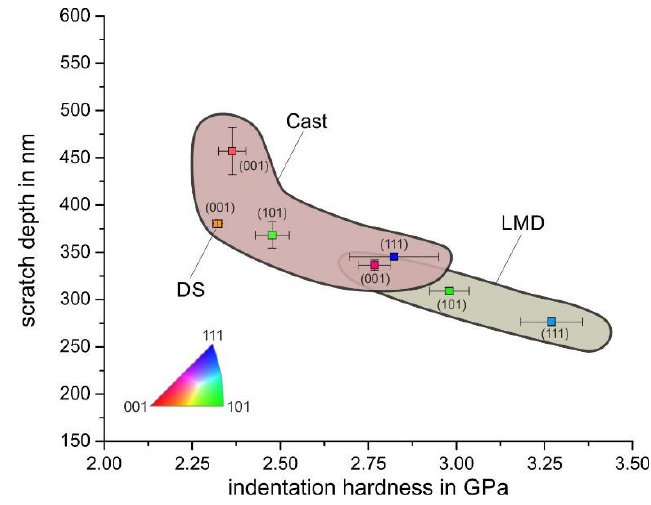
Figure 16. Relationship between scratch depth and hardness for different crystallographic orientations and processing routes.